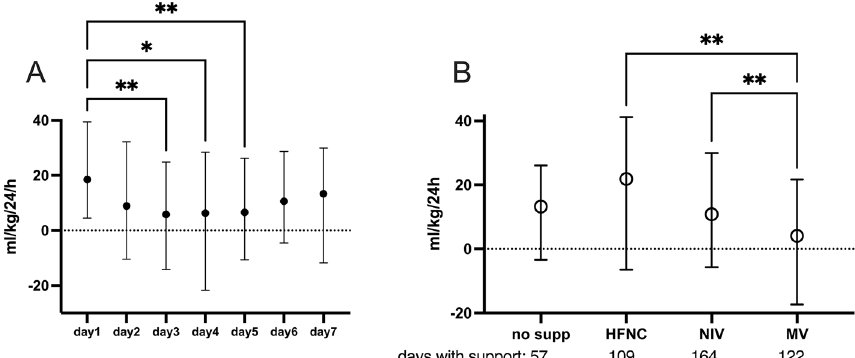
Fig. 1 A Daily fluid balances from day 1 to day 7 after Pediatric Intensive Care Unit admission showed to change significantly ( p hoc analysis, they showed significant differences between day 1 and days 2, 3, 4, and 5 respectively. B Daily fluid balances compared between different ventilatory modes: days spent with high flow nasal cannula (HFNC) and with non-invasive ventilation (NIV) including face mask and helmet, appeared to have significantly higher fluid balances with respect to those with mechanical ventilation (MV). Data are expressed as median and interquartile range. *Represents p < 0.01 and ** represents p < 0.001